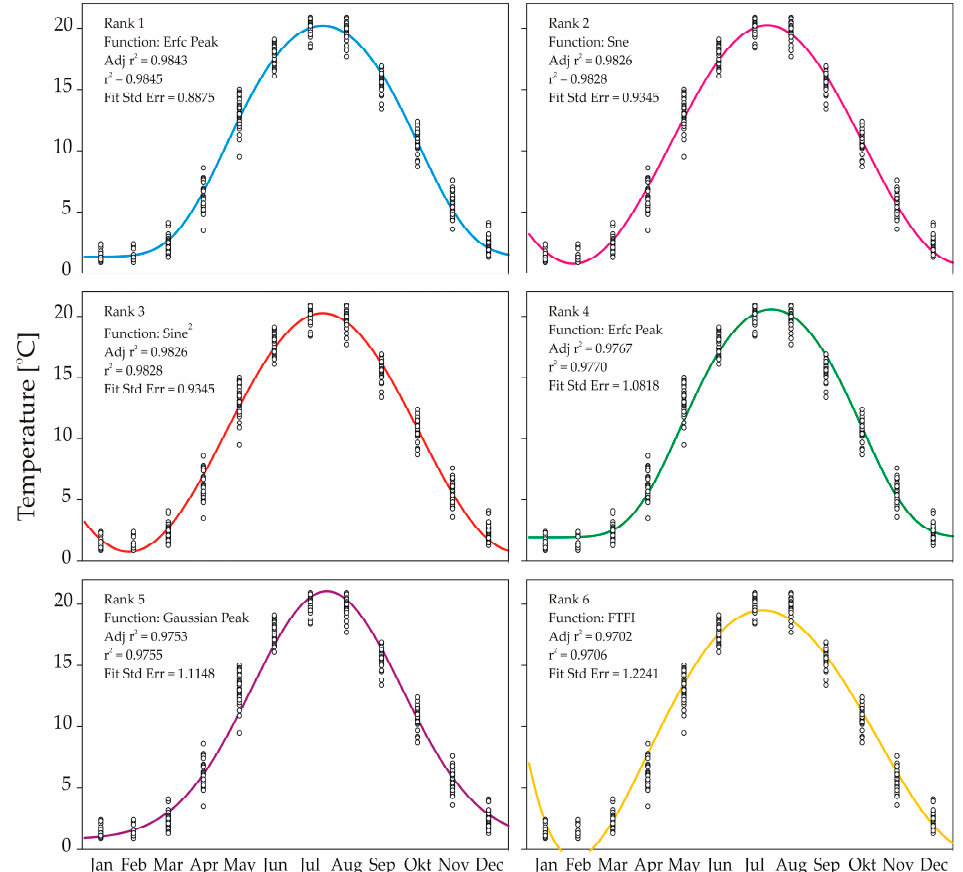
Figure 3. The annual course of surface water temperature (°C) in Polish lakes in the years 1971–2010 (according to data compiled by Sobolewski et al. [34] based on the data of the Institute of Meteorology and Water Management) and the six best linear fitting results and nonlinear models for these data in TableCurve software [64]. CEFP—complementary error function peak; FTFI—four term function with intercept. Table 3. Correlation of the values estimated with the six best models from Figure 3 to average monthly surface water temperature (°C) in Polish lakes in the years 1971–2010. Source: Author calculations according to data compiled by Sobolewski at al. [34] based on the data of the Institute of Meteorology and Water Management. Rank t Coefficient Correlation Coefficient p Value